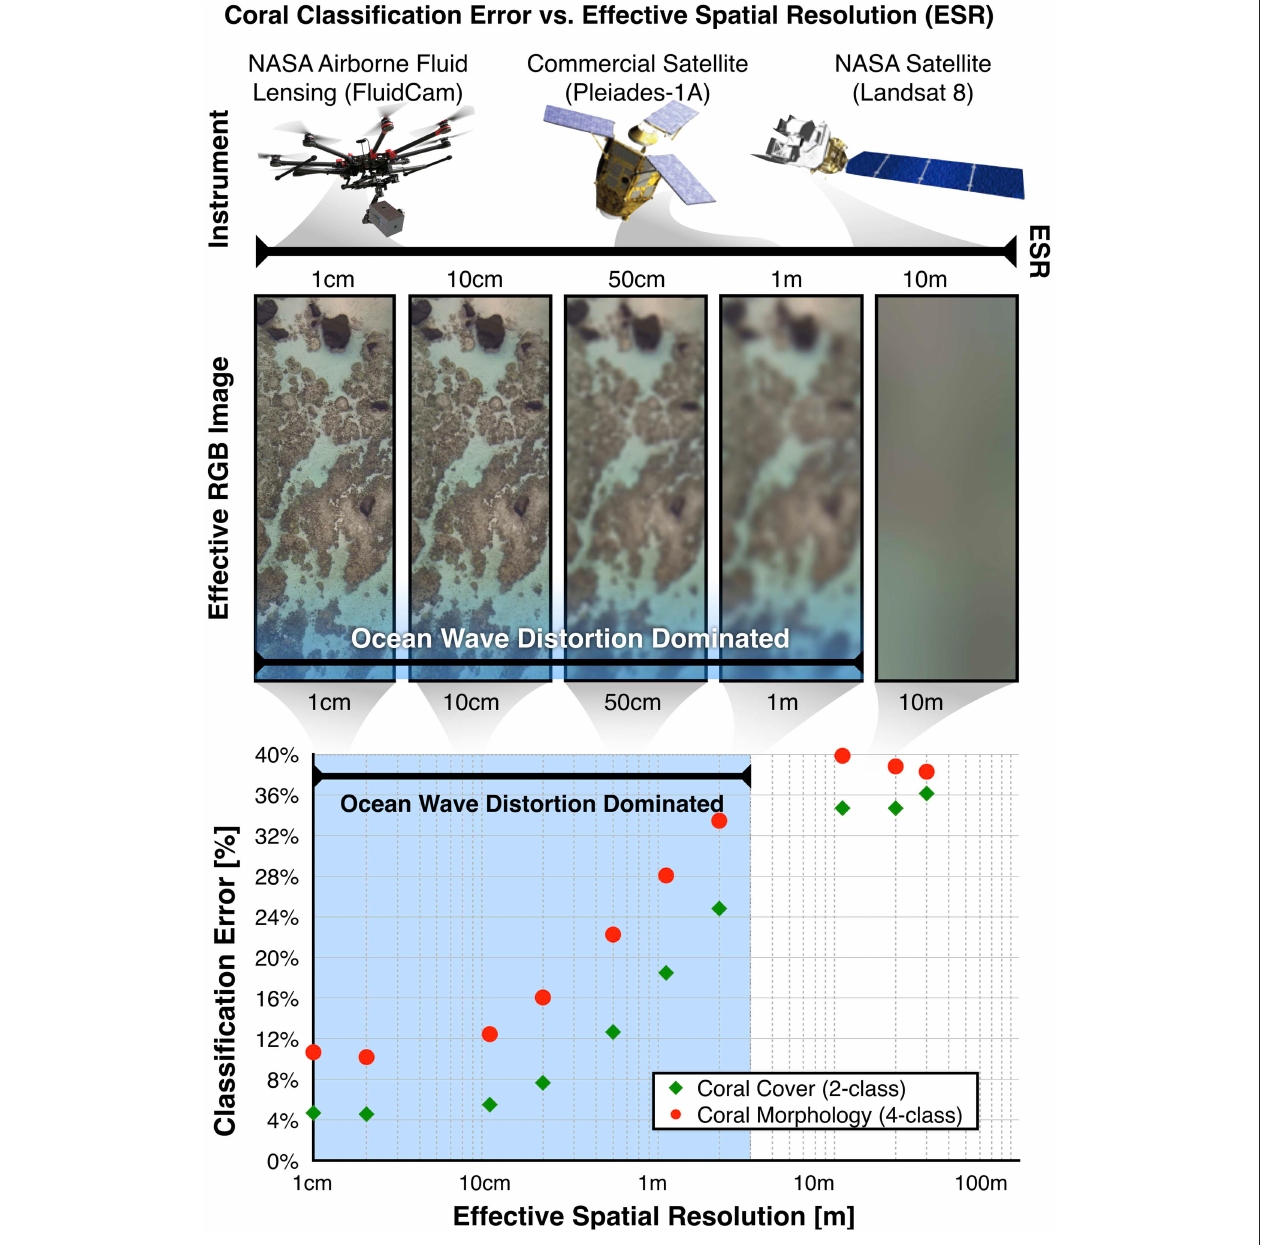
FIGURE 1 | Coral reef classification error as a function of effective spatial resolution (ESR). Using modern machine learning based habitat mapping, coral cover can determined with < 5% error at the cm spatial scale with fluid lensing and FluidCam, under a typical range of sea states, 18% error at the 1m scale from commercial platforms with a perfectly flat sea state, and 34% error at the 10m scale, typical of sustained land imaging satellites. Adapted with permission from Chirayath and Instrella